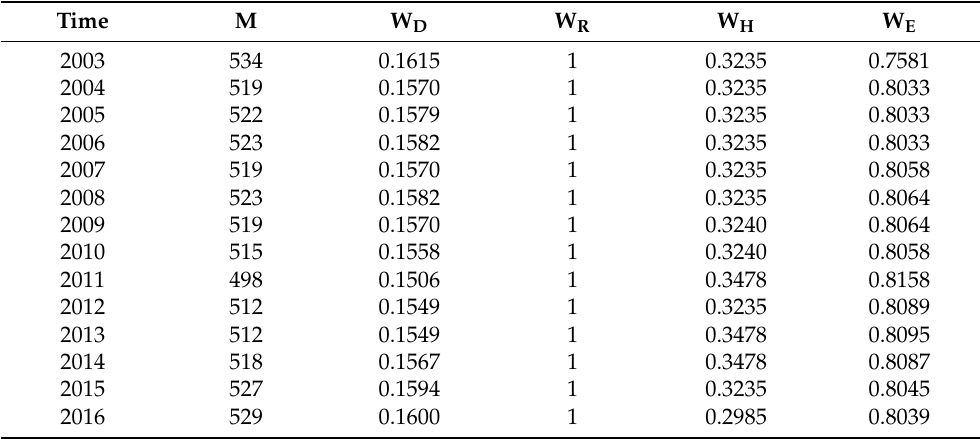
Table 9. Overall characteristics of the space networks for the energy consumption of Belt and Road